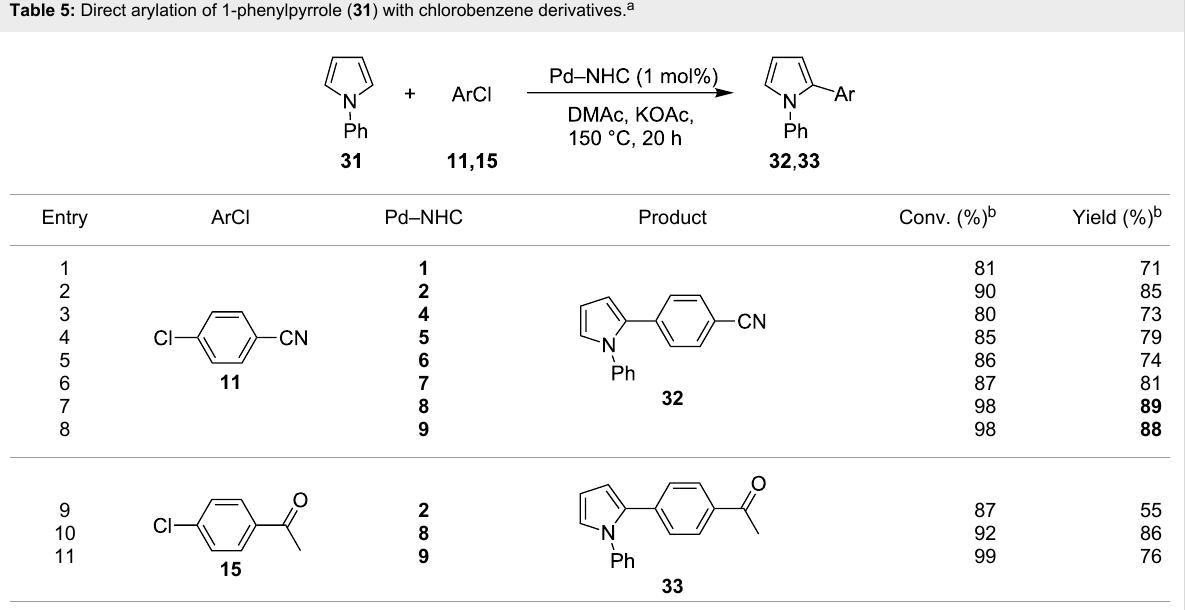
Table 5: Direct arylation of 1-phenylpyrrole ( 31 ) with chlorobenzene derivatives.